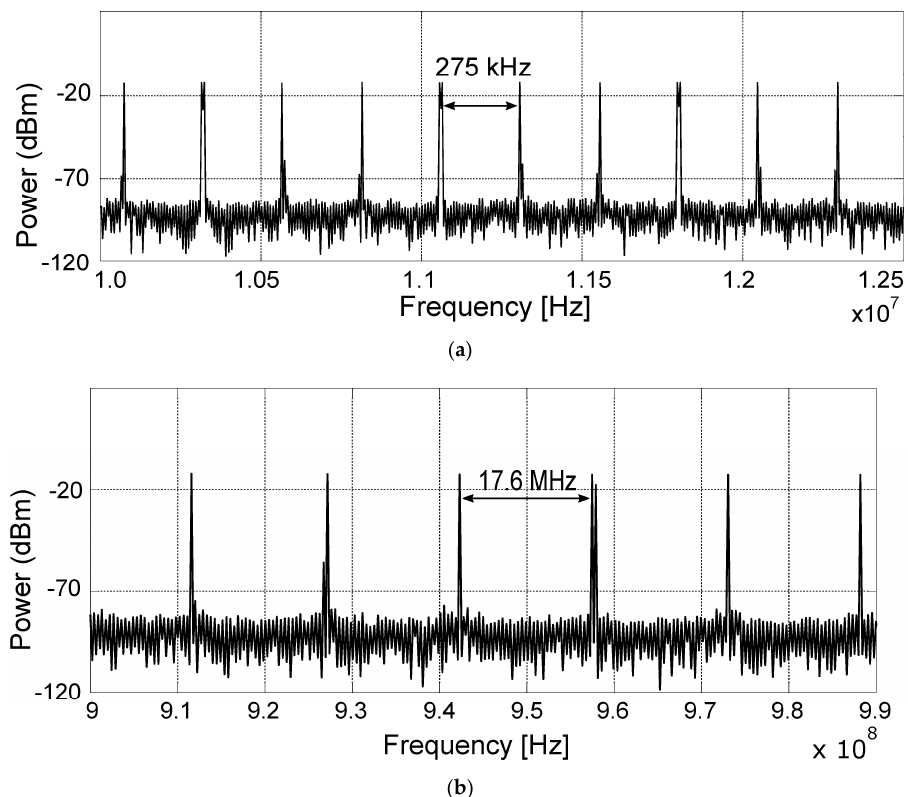
Figure 6. Comparison of spectral line spacing of signals transmitted by the 15th ( a ) and 9th ( b ) order M-sequence radars.